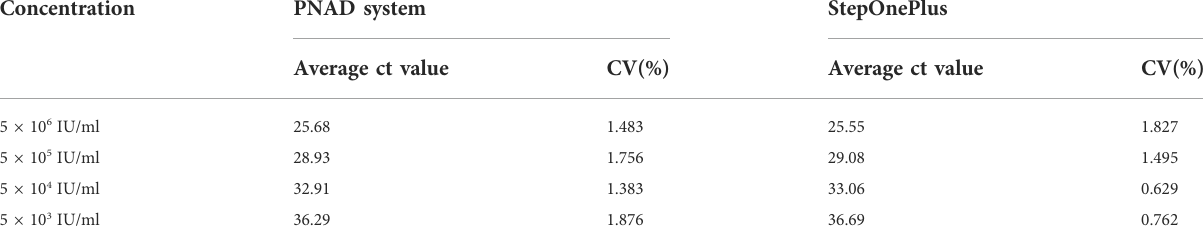
TABLE 4 Ct value and reproducibility of HBV concentration gradient test from the PNAD system and StepOnePlus system.